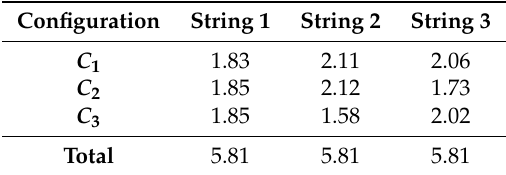
Table 4. Cell and string capacities (in (Ah) for Option 2) that best match capacity among the three